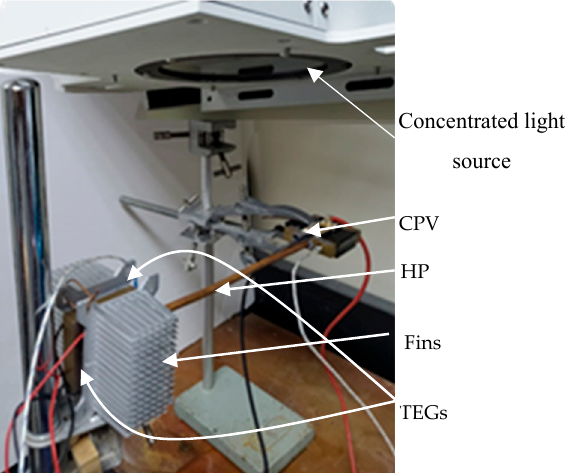
Figure 3. The setup used in the experiment.